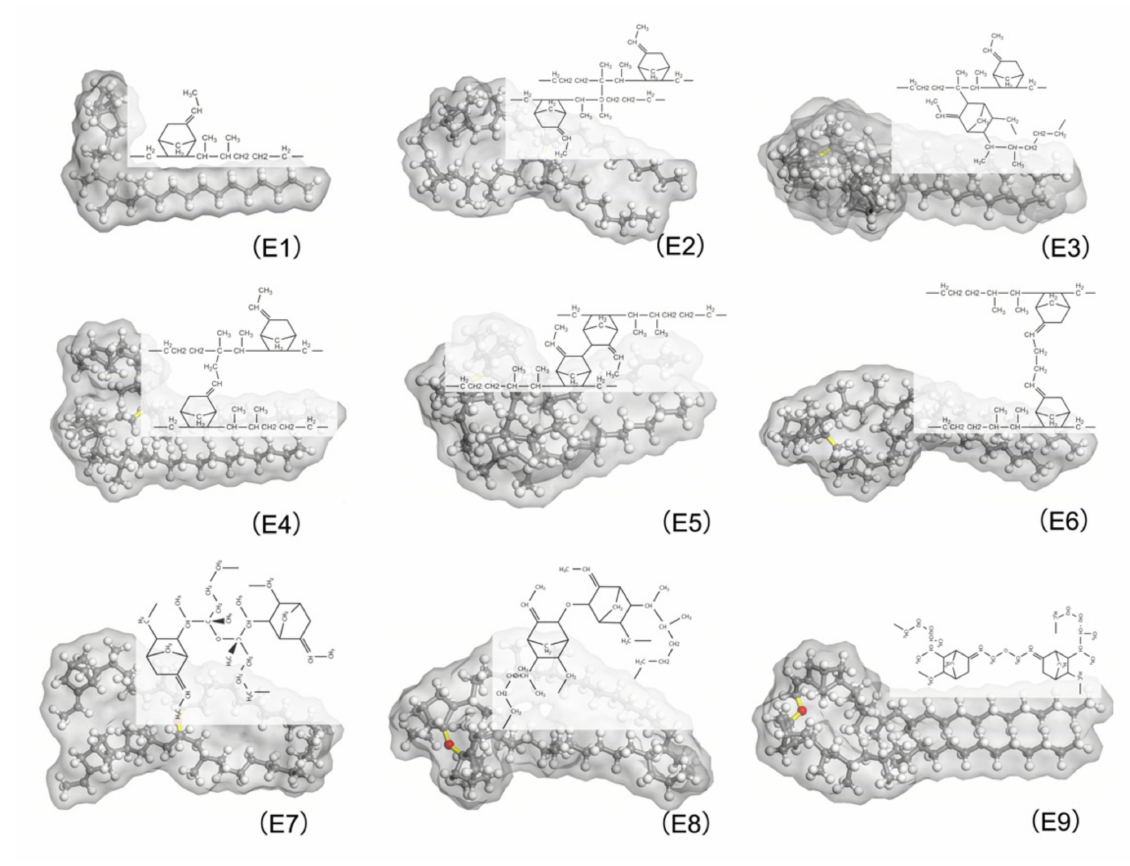
Figure 4. EPDM molecular chains with different cross-linking types, carbon atoms are shown in gray, hydrogen atoms in white, oxygen atoms in red, and cross-linking bonds in yellow. E1 was uncross-linked EPDM; E2, E3, E4, E5, E6, E7, E8, and E9 were EPDM with C2*-C2*, C2*-C3, C2-C9, C3-C3, C9-C9, C2*- O-C2*, C3-O-C3 and C9-O-C9 cross-links,